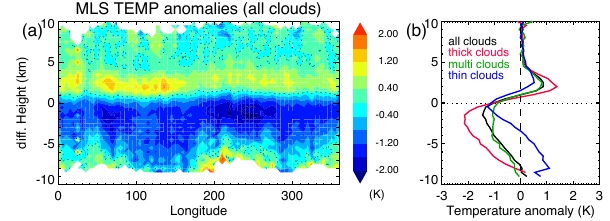
Fig. 4. As in Fig 3a except temperature anomalies are averaged according to their 3 Fig. 4. As in Fig. 3a except temperature anomalies are averaged according to their position relative to cloud top position relative to cloud top height. 4